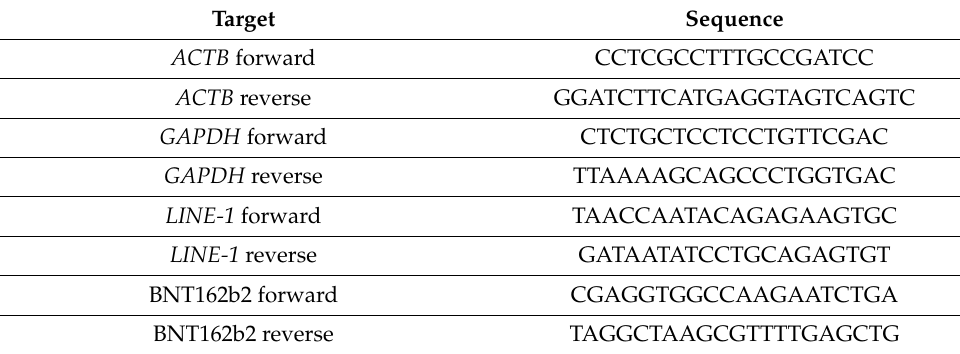
Table 1. Primer sequences of RT-qPCR and